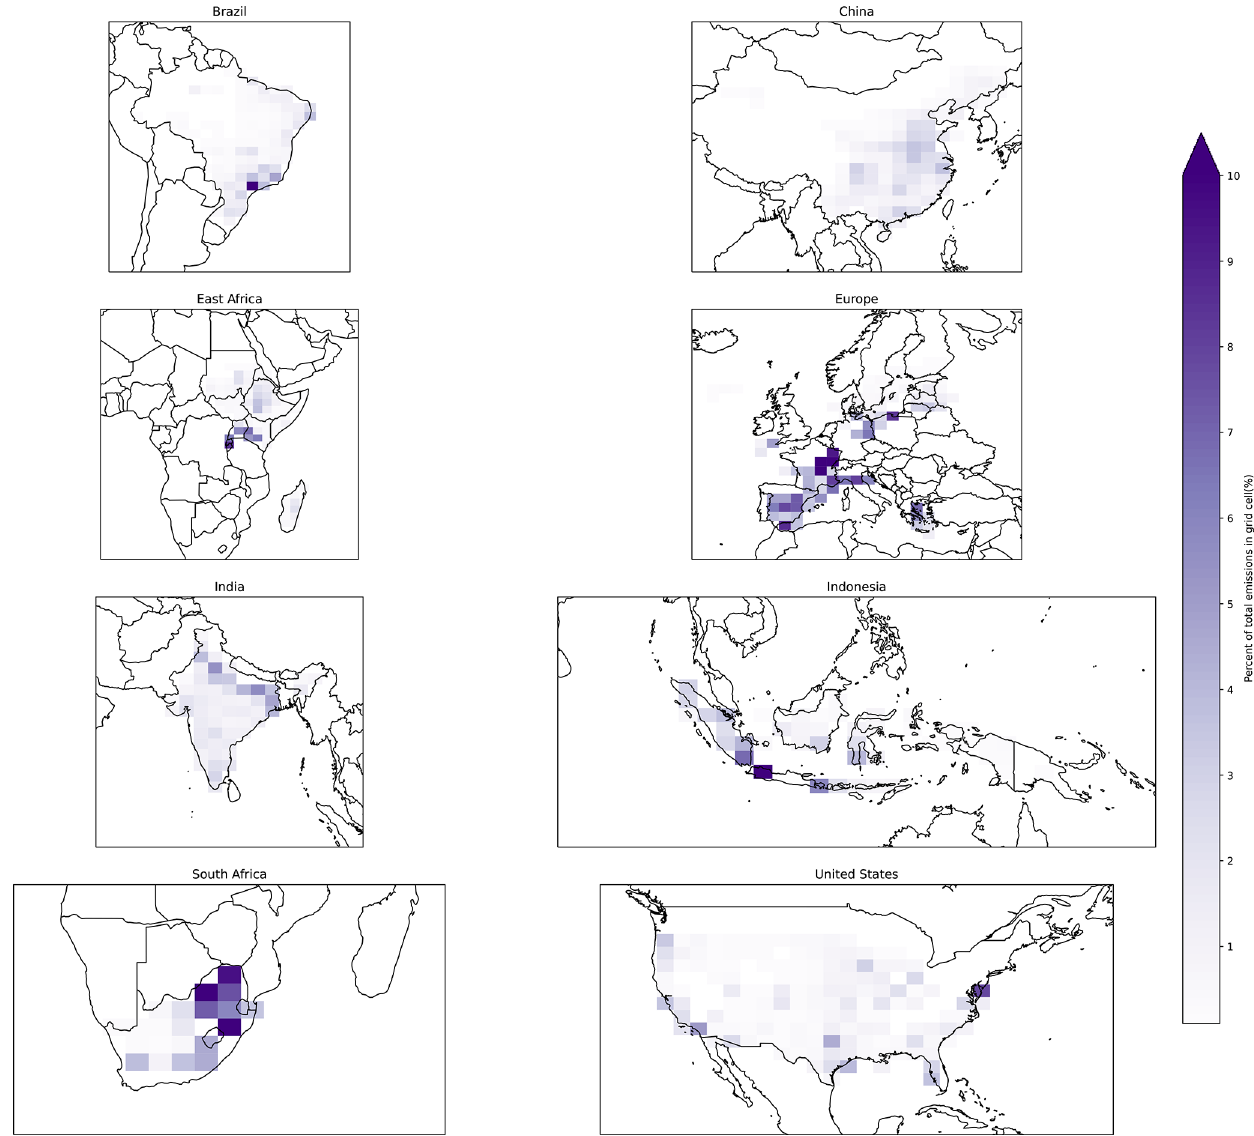
Figure A1. An identical total change in emissions is distributed within each of the eight perturbation regions according to patterns shown above. Distributions are shown in terms of the percent of the identical total emissions change that occurs within a given model grid cell within the region and follows the year 2000 realistic distribution of emissions within that